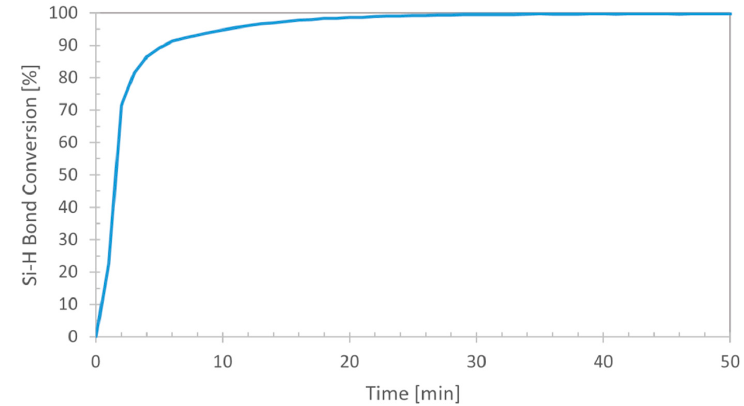
Figure 1. Surface plot illustrating the rate of changes in the area under the band at ˜ υ = 904 cm − 1 for the catalytic system studied.